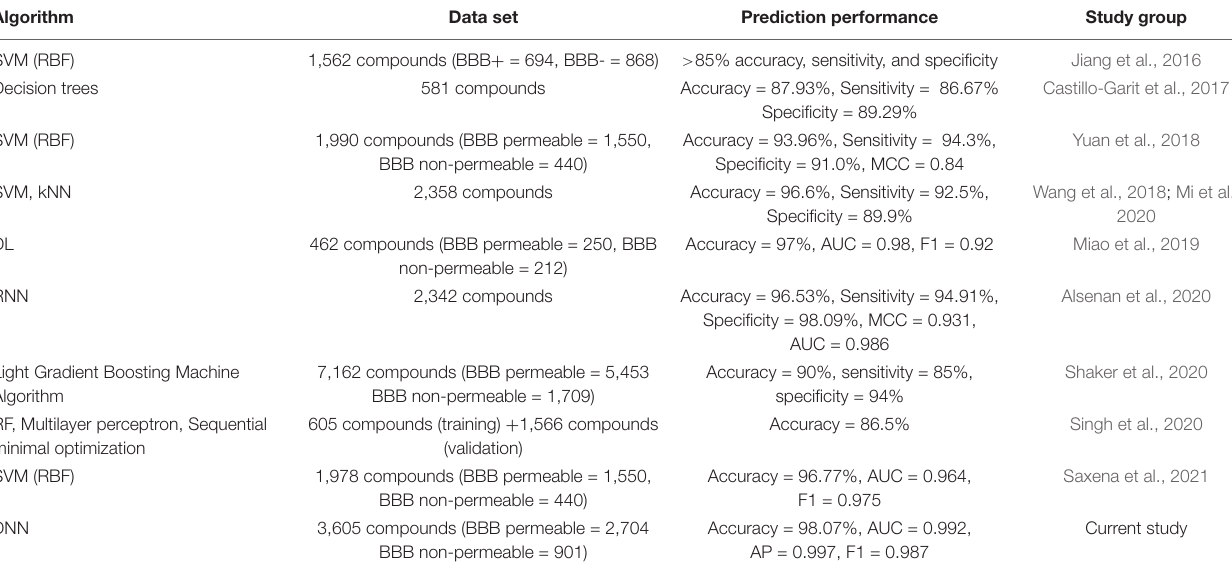
FIGURE 4 | Accuracy and loss plot of the DNN model for the prediction of BBB permeability. TABLE 7 | Comparative analysis of DeePred-BBB with recently published BBB permeability prediction